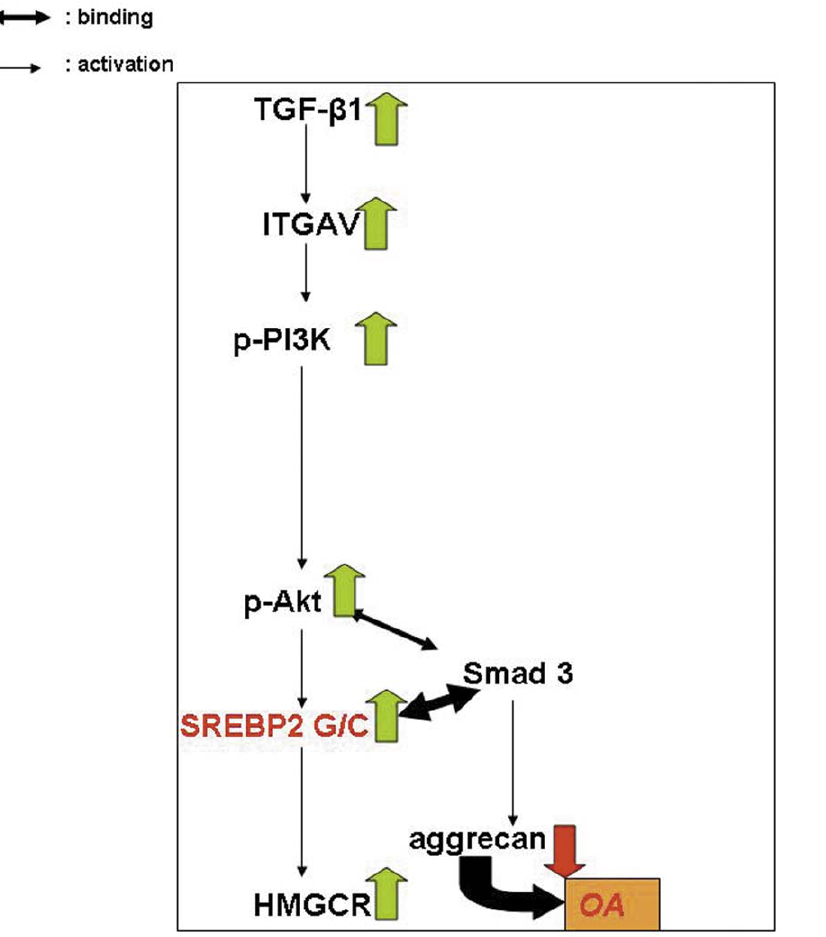
Figure 7. Schematic representation of the molecular pathway activated in osteoarthritic chondrocytes where the involvement of 1784G . C polymorphism is evident. Briefly, in OA, ITGAV and TGF- b upregulation leads to phospho-PI3K and phospho-Akt activation which in turn cause overexpression of SREBP-2 and its target gene HMGCR accompanied by increased levels of MMP-13. Interestingly, chondrocytes expressing the SREBP-2 G/C genotype bind stronger to Smad3 leading to ACAN downregulation, contributing thus to the osteoarthritic phenotype. Furthermore, inhibition of integrins in OA, leads to SREBP-2, HMGCR and MMP-13 downregulation with subsequent elevation of ACAN levels suggesting integrin blockage as a potential molecular target for OA